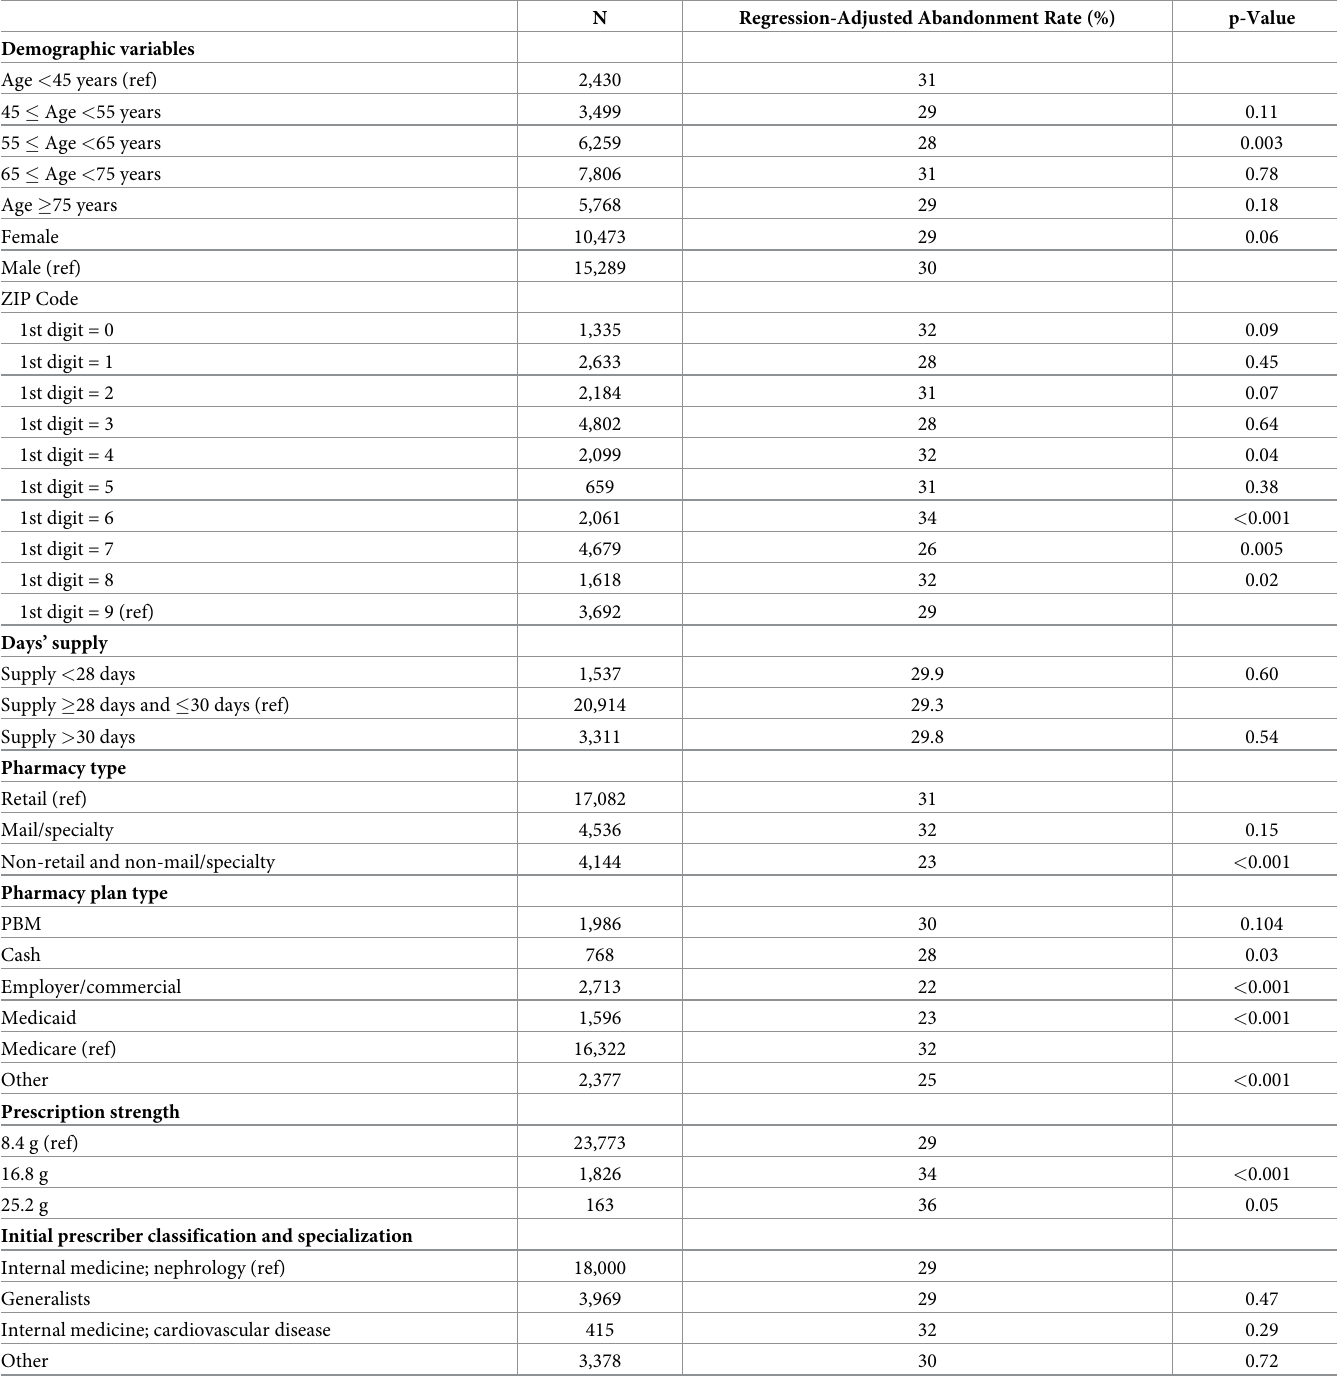
Table 4. Regression-adjusted percent of first patiromer prescriptions abandoned (N =